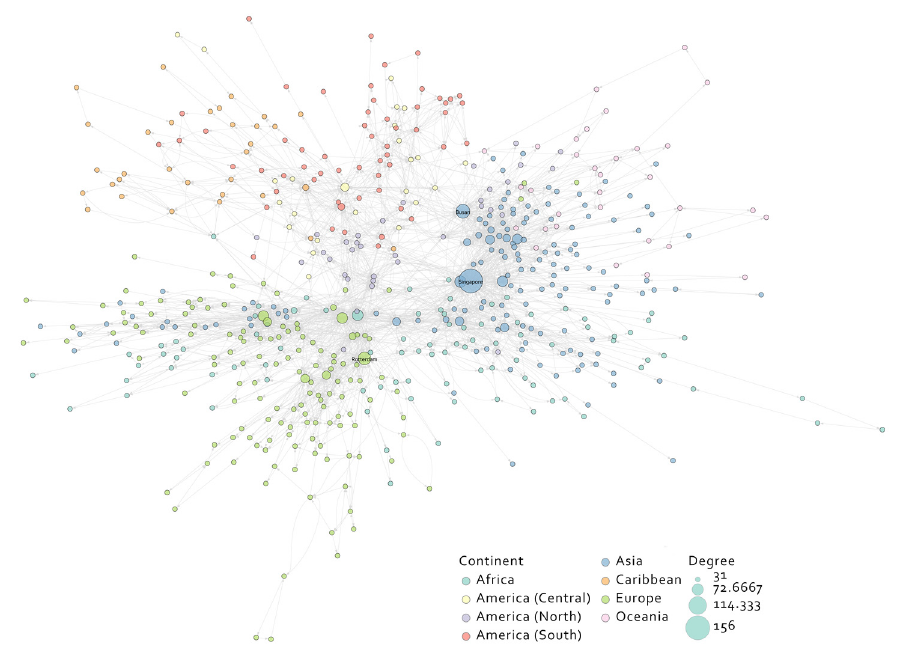
Figure 2. The GLSN. The size of a node is based on its degree; we set the size of nodes with a degree between 1 and 31 as the minimum and the size of nodes with a degree of 156 (Singapore) as the maximum. The color of the nodes in the diagram varies depending on the continent to which they belong. The continent classification is provided by IHS Markit.